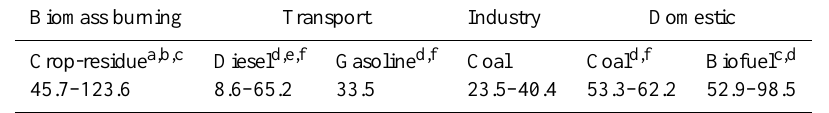
Table 2. Emission ratios of CO / CO 2 (ppbppm − 1 ), derived from emission factors (gram of gases emitted per kilogram of fuel burned).